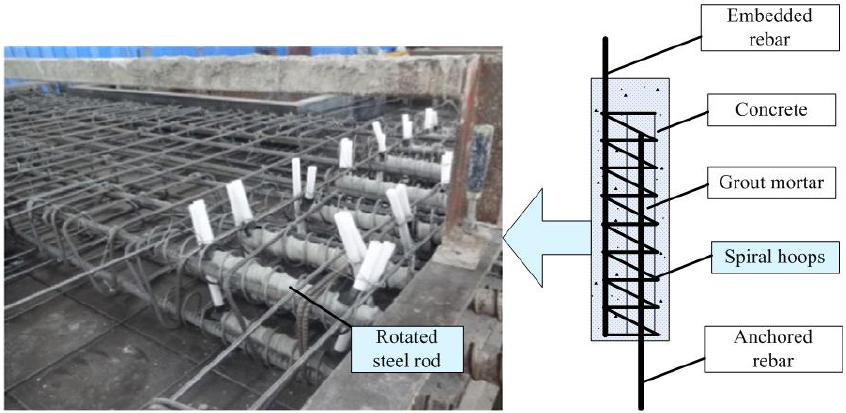
Figure 2. Lapped connection